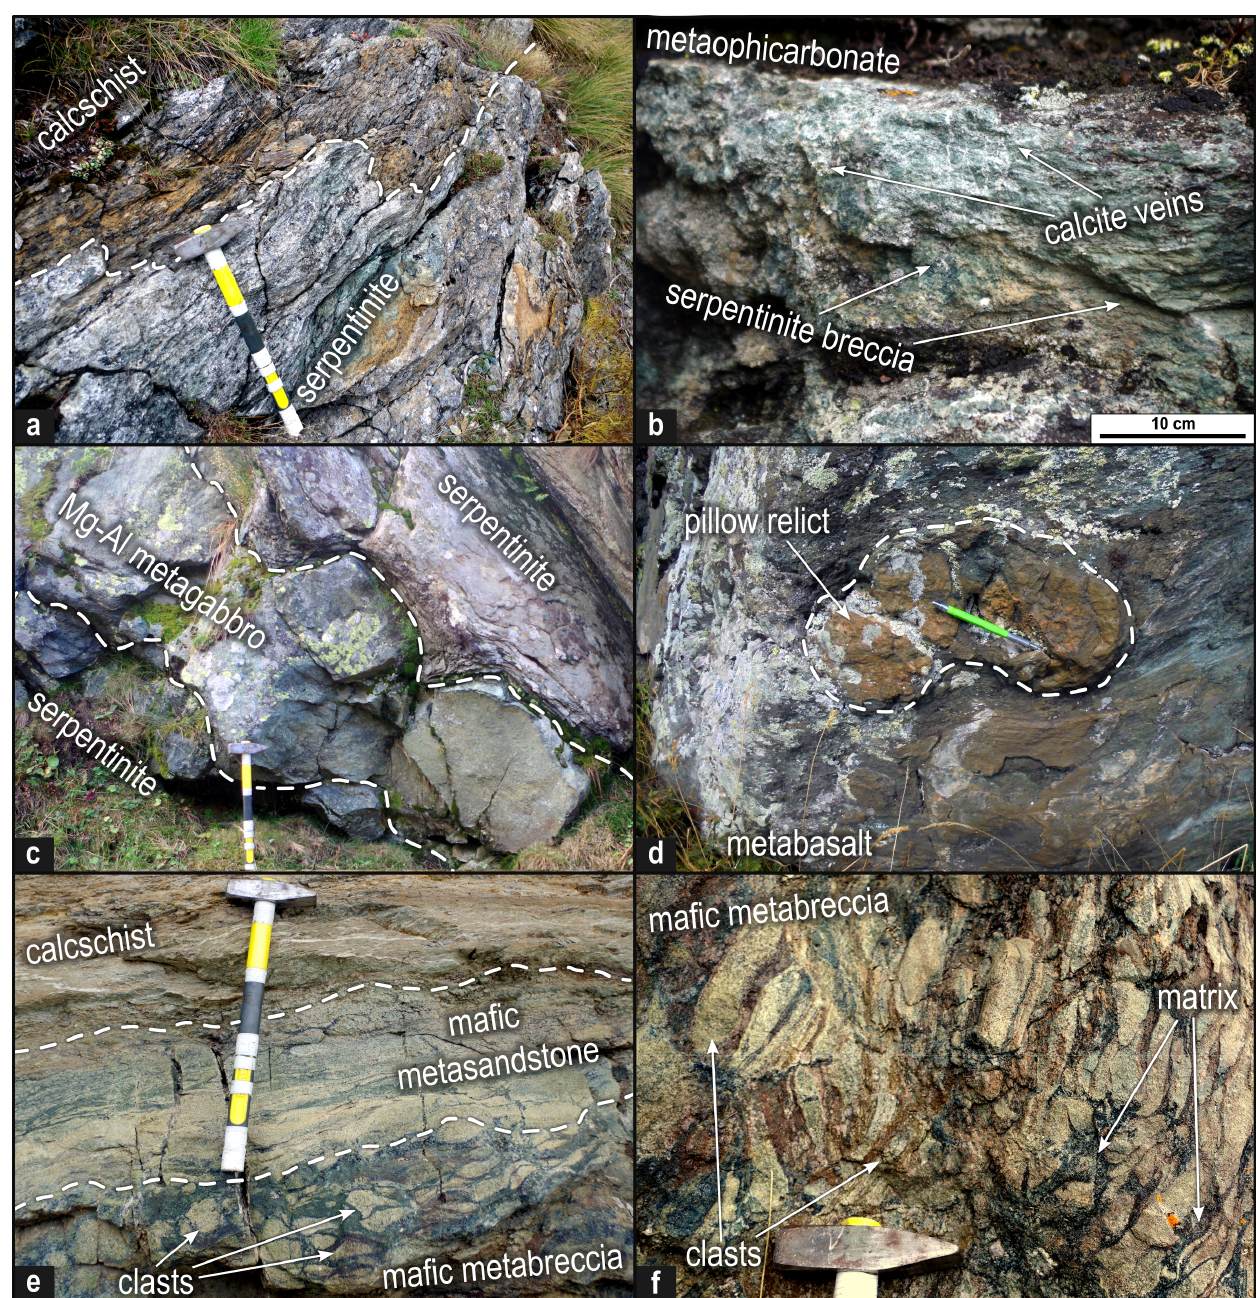
Figure 4. Field photographs of the main lithotypes , preserved primary stratigraphic contacts and relationships, and pre- alpine relict structures in the study area. ( a ) Folded stratigraphic contact between calcschist and serpentinite. 45 ◦ 12 (cid:48) 22.5 (cid:48)(cid:48) N 7 ◦ 09 (cid:48) 10.6 (cid:48)(cid:48) E. ( b ) Close-up view of metaophicarbonate horizon between serpentinite and calcschist, showing a brecciated structure as well as thin, anastomosing calcite veins. 45 ◦ 12 (cid:48) 23.2 (cid:48)(cid:48) N 7 ◦ 09 (cid:48) 12.5 (cid:48)(cid:48) E. ( c ) Boudinated Mg-Al metagabbro body embedded in foliated serpentinite. 45 ◦ 12 (cid:48) 24.3 (cid:48)(cid:48) N 7 ◦ 08 (cid:48) 58.0 (cid:48)(cid:48) E. ( d ) Metabasalt showing relicts of pillow structure inside a fine-grained mafic matrix. 45 ◦ 11 (cid:48) 42.9 (cid:48)(cid:48) N 7 ◦ 08 (cid:48) 52.1 (cid:48)(cid:48) E. ( e ) Mafic paraderivate horizon interlayered in calcareous calcschist, in which mafic metabreccia (made up of greenish sub-angular clasts and a bluish fine-grained matrix) passes upwards to medium- to fine-grained mafic metasandstone, which displays a relict graded texture. 45 ◦ 12 (cid:48) 25.9 (cid:48)(cid:48) N 7 ◦ 08 (cid:48) 56.0 (cid:48)(cid:48) E. ( f ) Detail of the relict texture in mafic metabreccia, highlighting the size and the shape of the recrystallized clasts, embedded in a fine grained matrix. 45 ◦ 12 (cid:48) 25.9 (cid:48)(cid:48) N 7 ◦ 08 (cid:48) 56.0 (cid:48)(cid:48)